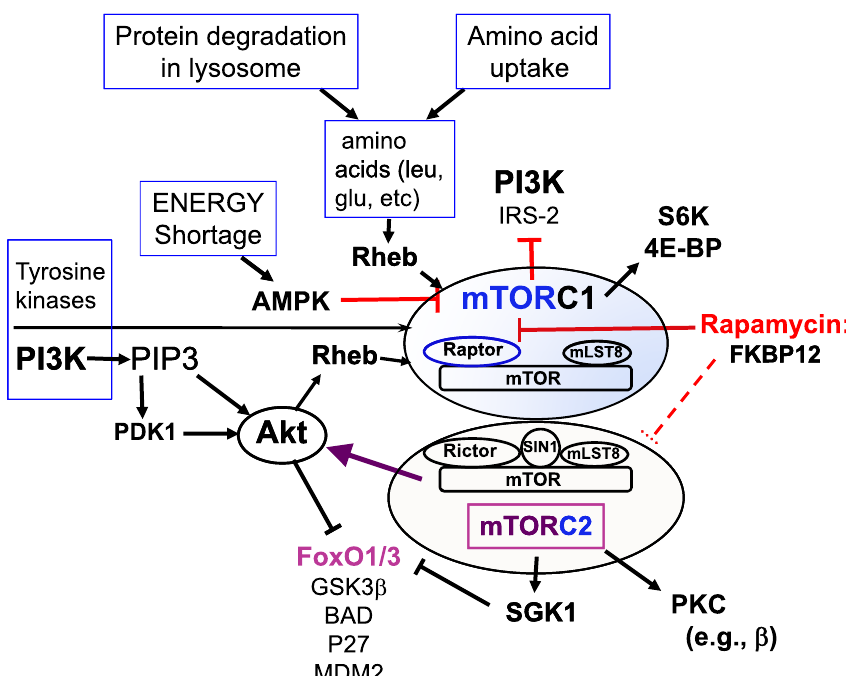
Figure 1. A simplified summary of the two distinct mammalian (or mechanistic) target of rapamycin (mTOR) signaling complexes, with some of the inputs (activators) and outputs. Details are outlined in the